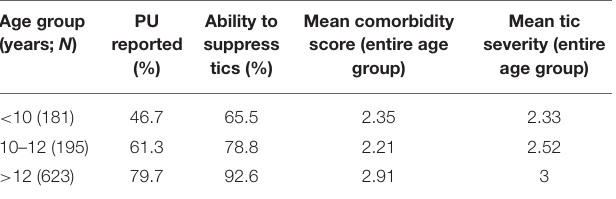
* according to STSS-GSR PU, premonitory urge; STSS-GSR, Global Severity Rating of the Shapiro Tourette- Syndrome Severity Scale; N, numbers.